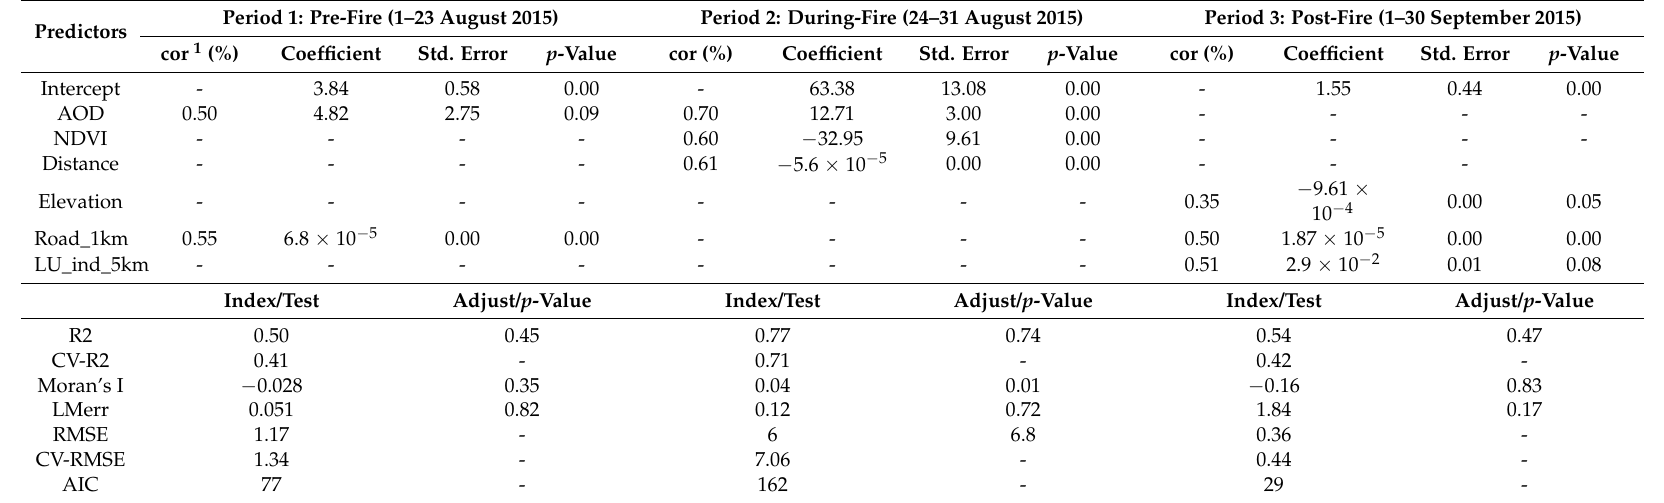
1 : Correlation between PM 2.5 and predictors in each